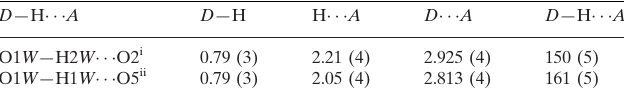
Hydrogen-bond geometry (A˚ , (cid:3)